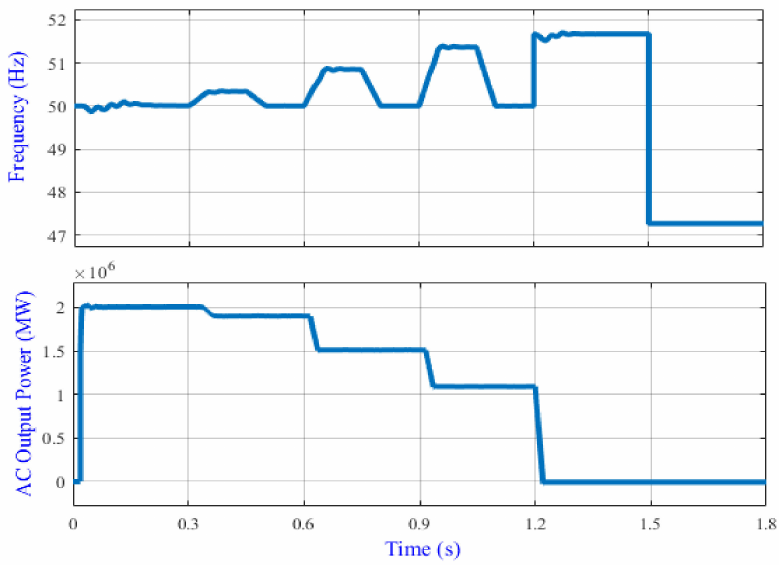
Figure 19. Active power control behavior during frequency deviation.